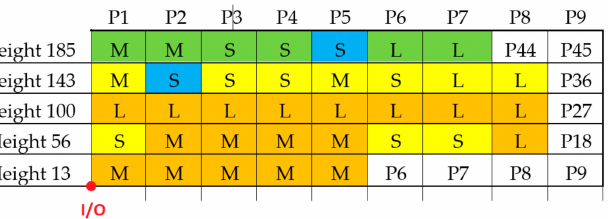
Figure 7. Storage assignment proposal based on minimization of the energy-based objective function (scenario 3, short